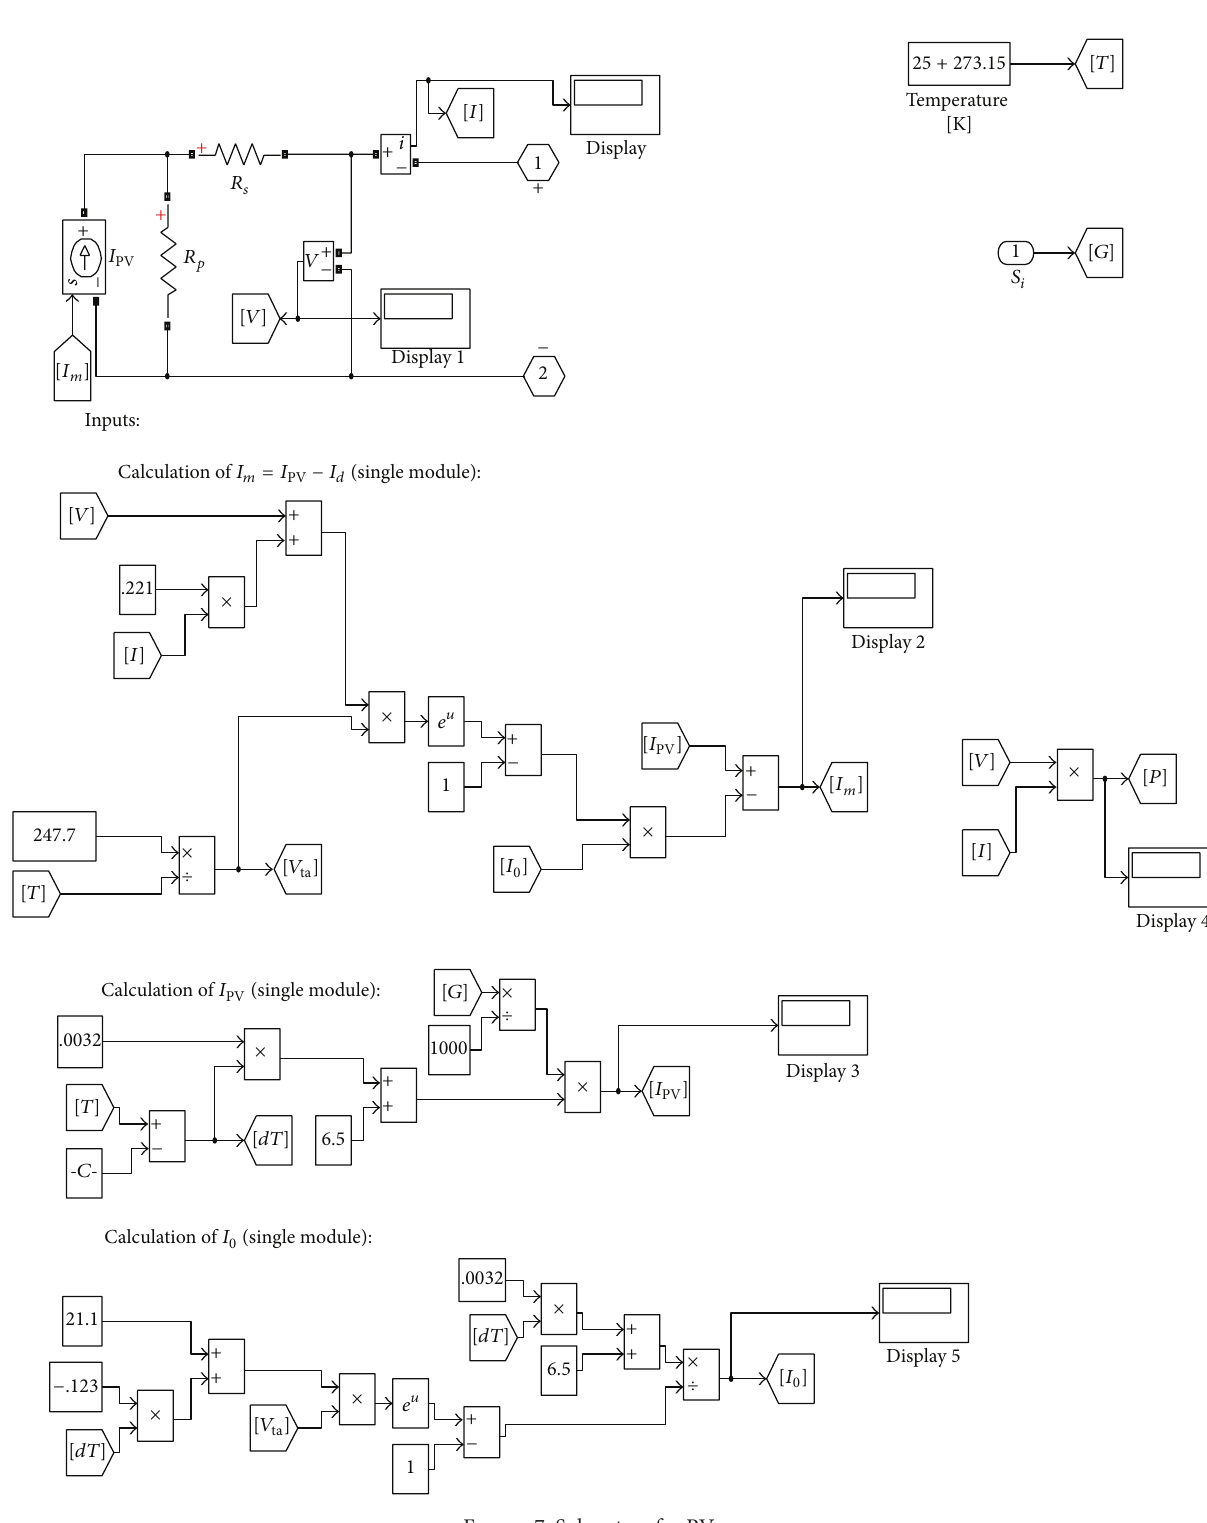
Figure 7: Subsystem for PV